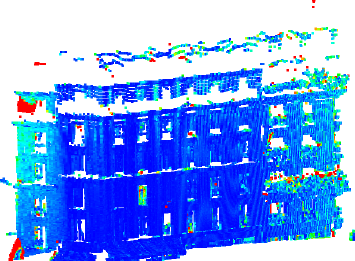
Figure 13: Registration accuracy for the MMS dataset (optimal configuration), colored according to ¯ t (0 m (blue) → 5 cm and more